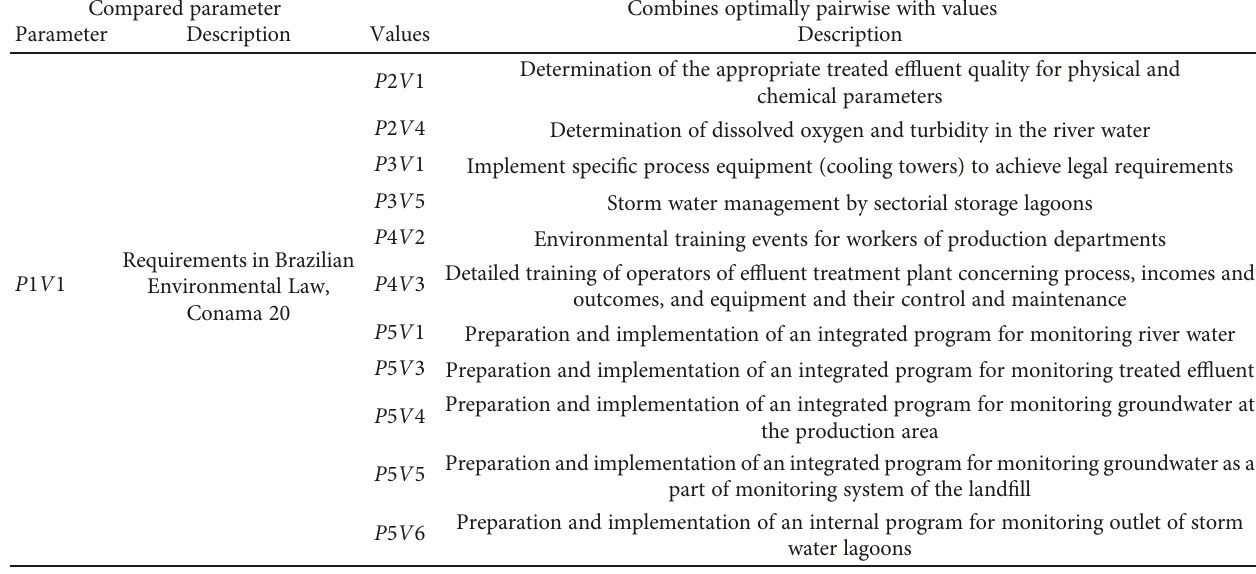
Table 3: Detailed description of the parameters that combine optimally pairwise in policy 1. Compared